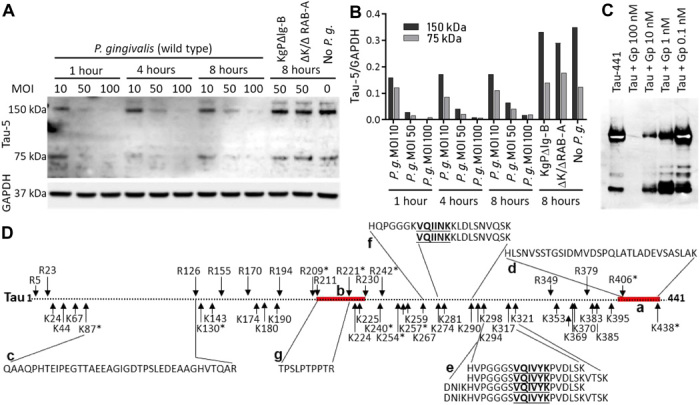
P. gingivalis and gingipains fragment tau.(A) WB analysis of total soluble tau in SH-SY5Y cells infected with increasing concentrations of wild-type (WT) P. gingivalis strain W83 (P.g.) and P. gingivalis gingipain-deficient mutants either lacking Kgp activity (KgpΔIg-B) or lacking both Kgp and Rgp activity (ΔK/ΔRAB-A). Uninfected SH-SY5Y cells (No P.g.) were used as a negative control. Glyceraldehyde-phosphate dehydrogenase (GAPDH) was used as a loading control. Total tau was monitored with the monoclonal antibody Tau-5 at 1, 4, and 8 hours after infection. (B) Densitometry analysis of the total tau WB images. (C) WB analysis of rtau-441 incubated with purified Kgp and RgpB catalytic domains combined (Gp) at various concentrations for 1 hour at 37°C. The blot was probed with tau monoclonal antibody T46. (D) Gingipain cleavage sites in rtau-441 deduced from peptide fragments identified by MS for rtau-441 incubated with 1 or 10 nM gingipains. (a) T46 antibody epitope (red). (b) Tau-5 antibody epitope (red). (c) N-terminal tau fragment. (d) C-terminal tau fragment. (e) Kgp-generated tau fragments containing the VQIVYK sequence. (f) Kgp-generated fragments containing the VQIINK sequence. (g) An RgpB-generated tau fragment. *Cleavage sites identified at 1 nM gingipains.